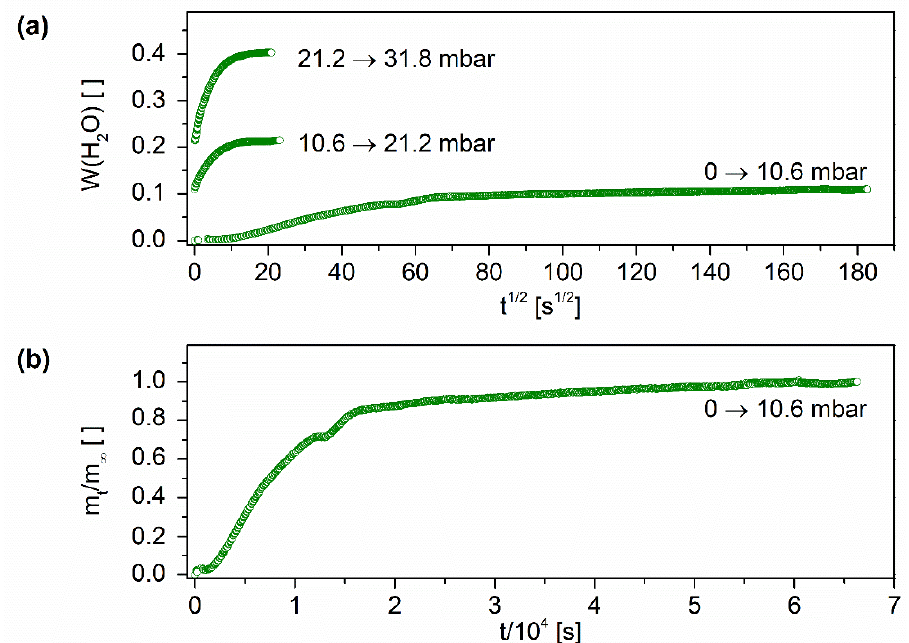
Figure 4. Interval sorption curves of poly(VEImBr) and water ( a ) for different pressure steps up to 31.8 ± 0.2 mbar; ( b ) plotted as the relative mass increase over time for the first pressure step up to 10.6 mbar (30 ± 1 °C; MBAA: 2 mol%).